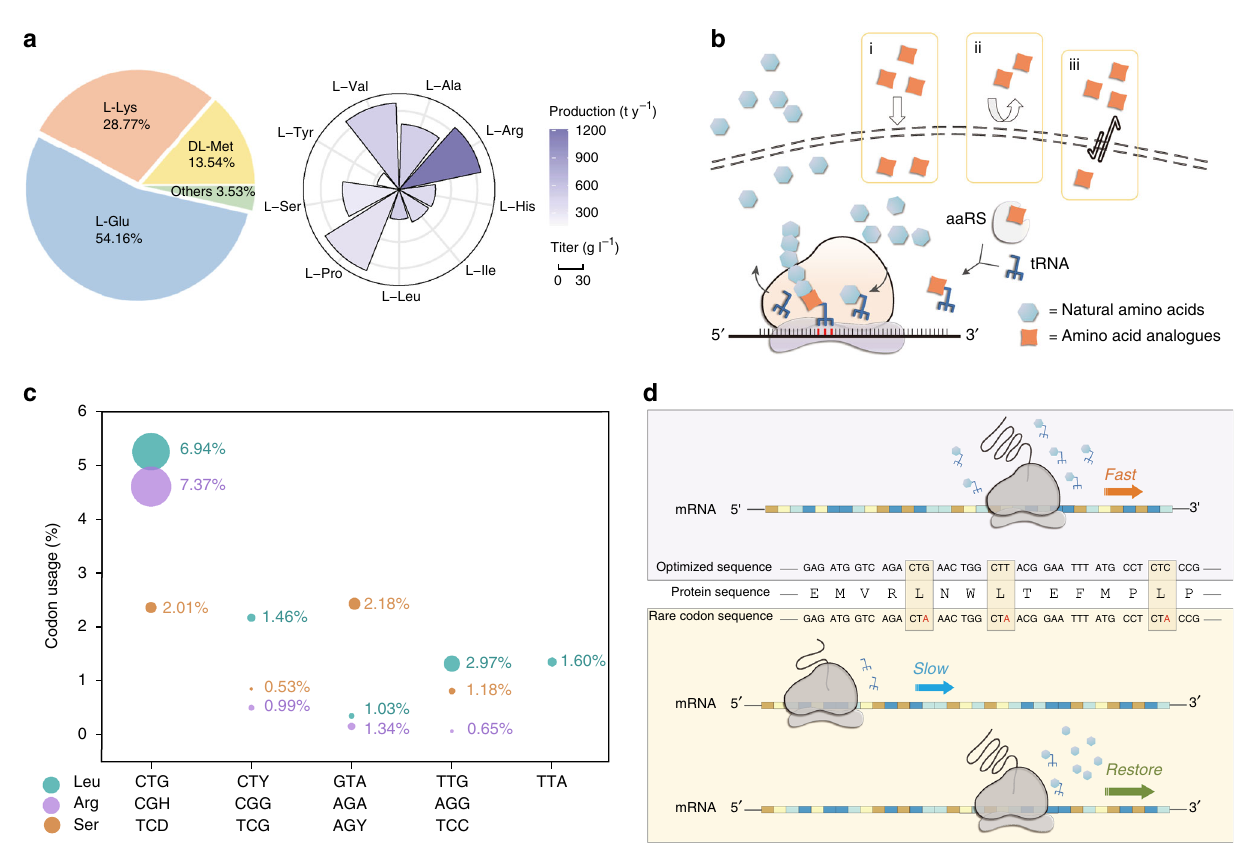
Fig. 1 Amino acid productions and codon usage. a Global productions of amino acids (left), the annual productions (right, represented by color intensity), and the fermentation titer (right, represented by bar height) for nine selected amino acids. b After taken up by the cells (i), the amino acid analogues (orange square) compete with the corresponding natural amino acids (blue hexagon) for the fi nite tRNAs, a step catalyzed by the aminoacyl-tRNA synthetase (aaRS). The analogues could be blocked (ii) or pumped outside of the cells (iii). c Codon usage and the fraction of tRNAs (bubble diameter) in E. coli 22 . The fraction of individual tRNA out of the total tRNA was derived from E. coli W1485, a K strain derivative at a growth rate of 0.4 doublings h – 1 . d For an exogenous gene, replacing its codons (e.g. leucine codon) with synonymous ones that are recognized by the most abundant tRNAs for a speci fi c host would typically improve the expression of the desired protein (upper box). On the contrary, the rare tRNAs have lower chances to be charged with the corresponding amino acids, switching to the rare alternatives (e.g. leucine codon CTA for E. coli ) that pair with the low-abundance tRNAs would dramatically slow down protein expression (lower box). Theoretically, the retarded protein expression should be restored by increased intracellular concentrations of the corresponding amino